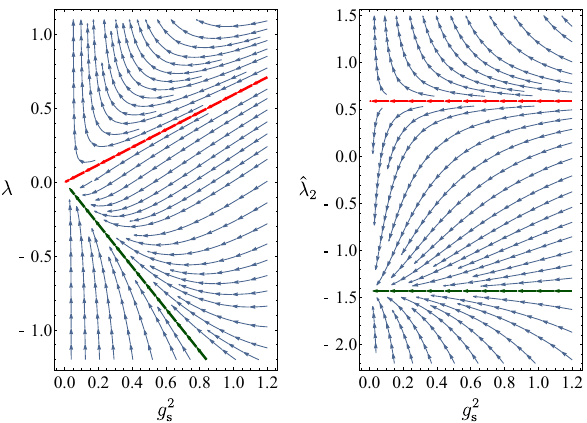
Fig. 3 Left Panel : one-loop RG flow of the quartic scalar coupling λ of the model with SM-like matter content as a function of g 2 s , using the special trajectory defined by Eq. (30). Right Panel : RG flow for the rescaled quartic coupling ˆ λ 2 , defined in Eq. (32) with P = 1 / 2, as a function of g 2 s . The red and green lines correspond to the UV-repulsive and attractive trajectories, respectively, corresponding to the roots ˆ λ ± in Eq.